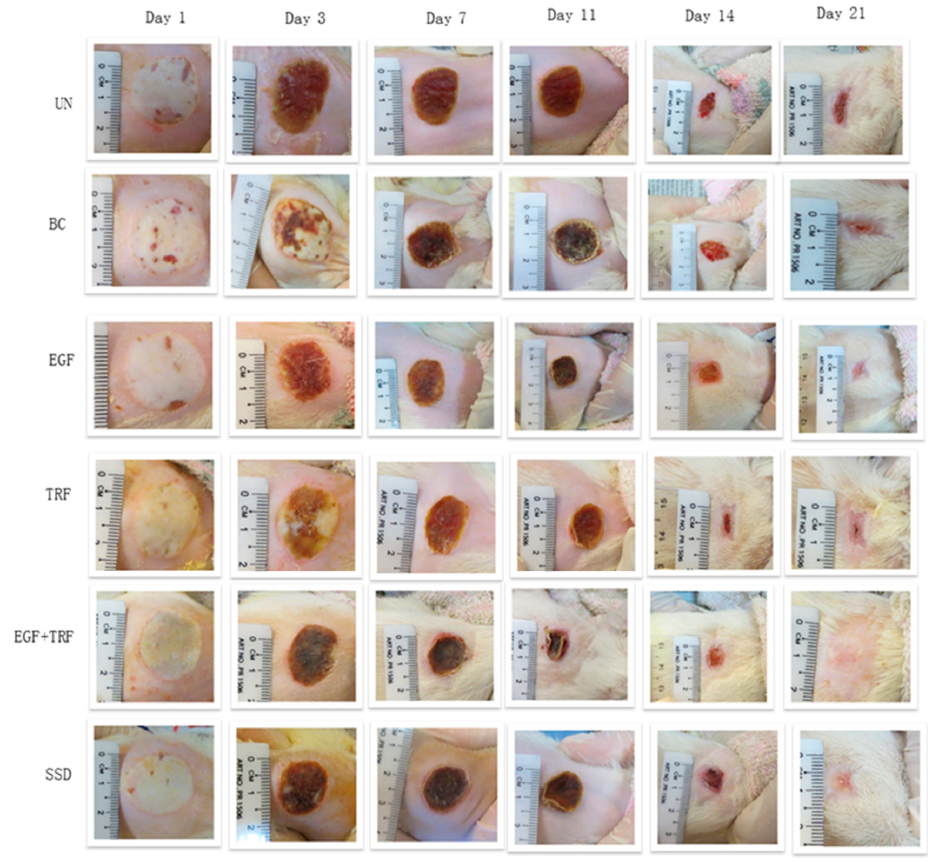
Figure 1. Macroscopic changes of deep partial-thickness burn wounds over time in Spraque-Dawley rats. UN: without any treatment, BC: treated with base cream, Epidermal growth factor (EGF): treated with base cream containing c% EGF, Tocotrienol-rich fraction (TRF): treated with base cream containing 3% TRF, EGF + TRF: treated with base cream containing both c% EGF and 3% TRF, and Silverdin ® cream (SSD): treated with SSD cream.